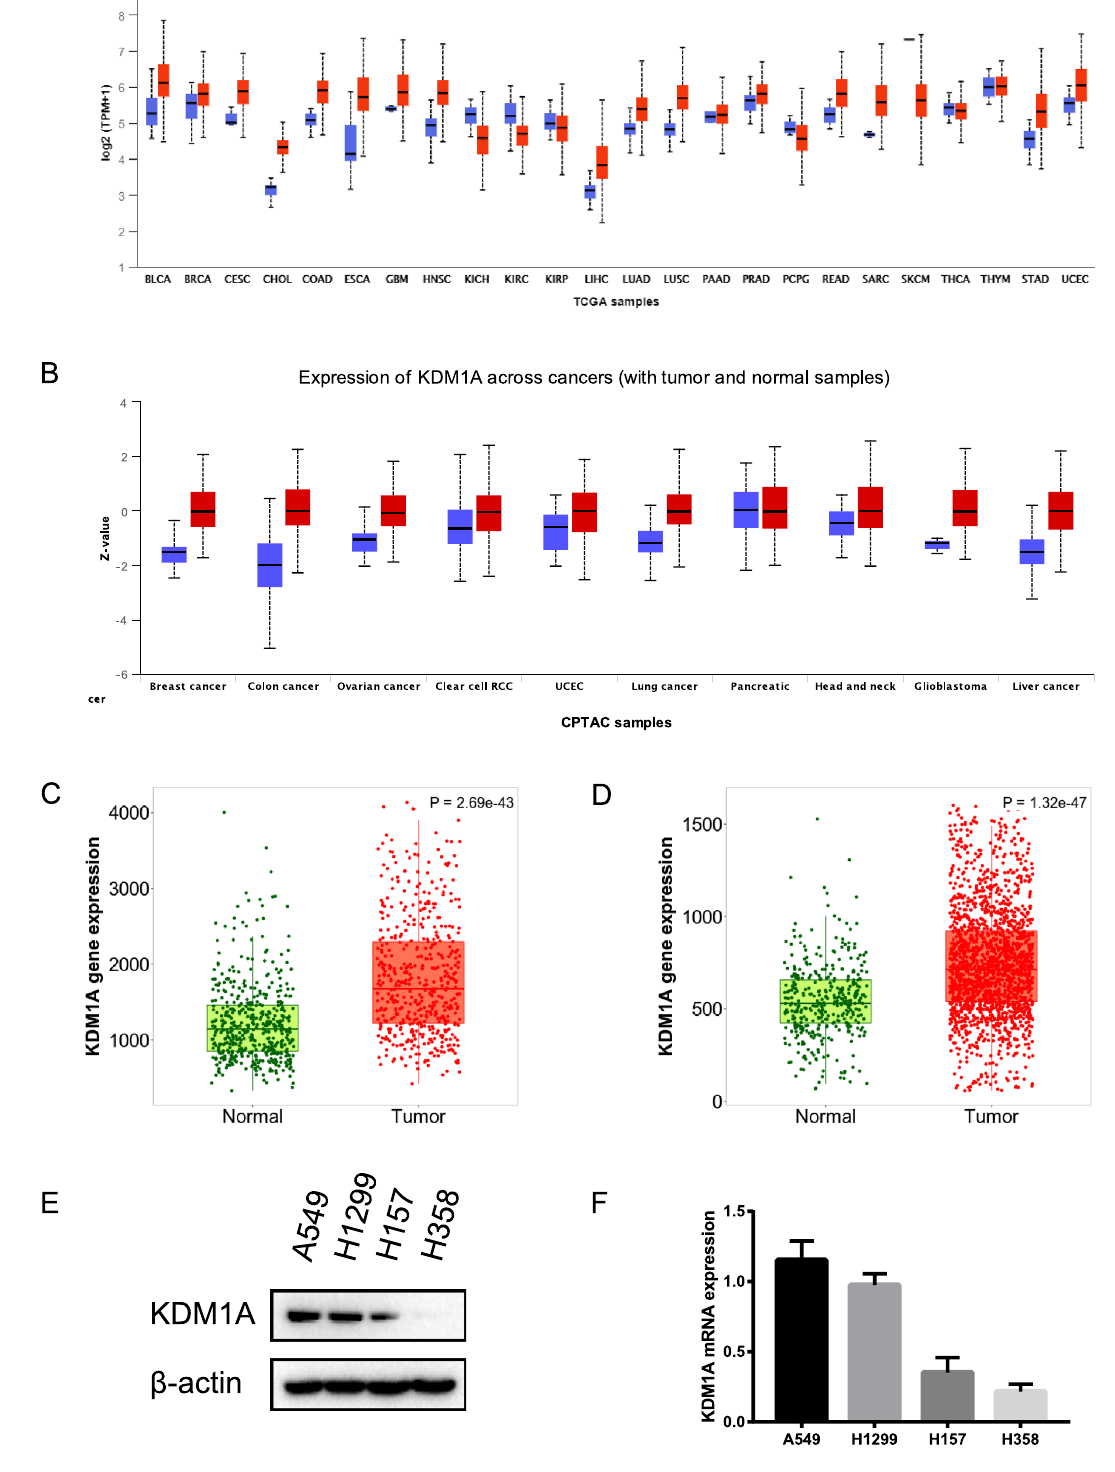
Figure 1. KDM1A was over-expressed in lung cancer tissues and cells. ( A ) Pan-cancer analysis of KDM1A expression profiles using UALCAN database. Red box refers to the tumor and blue box refers to the normal tissues. ( B ) Pan- cancer analysis of KDM1A protein expression in the CPTAC database from UALCAN. Red box refers to the tumor and blue box refers to the normal tissues. (C-D) KDM1A expression was higher than normal tissues analyzed from RNA- Seq data ( C ) and Gene-chip data ( D ) from TNMplot database. ( E , F ) The KDM1A protein and mRNA levels in four lung cancer cells, A549, H1299, H157 and H358 cells. According to the molecular weight, the nitrocellulose membrane was cut prior to hybridization with antibodies and the original blots are presented in Supplementary Fig.